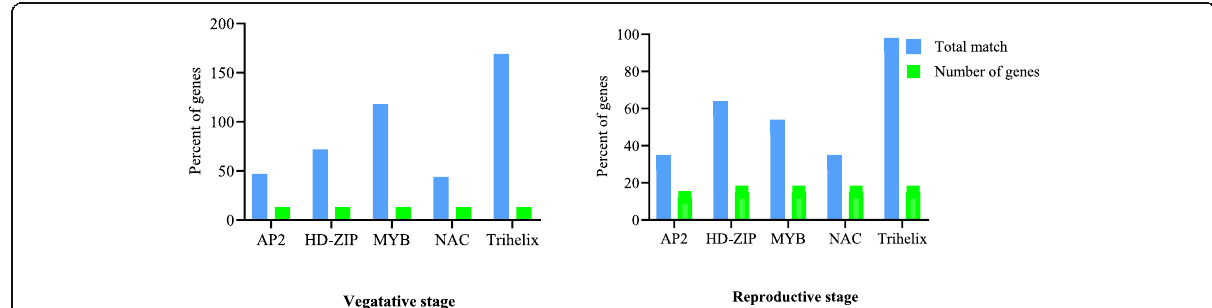
Fig. 6 Transcription factor families with binding sites in more than 85% ( P value < 0.05) of the hub genes. Blue bar, the number of binding sites of these transcription factors predicted in the promoters of the hub genes; green bar, the number of hub genes having binding sites of these transcription factors in the promoters